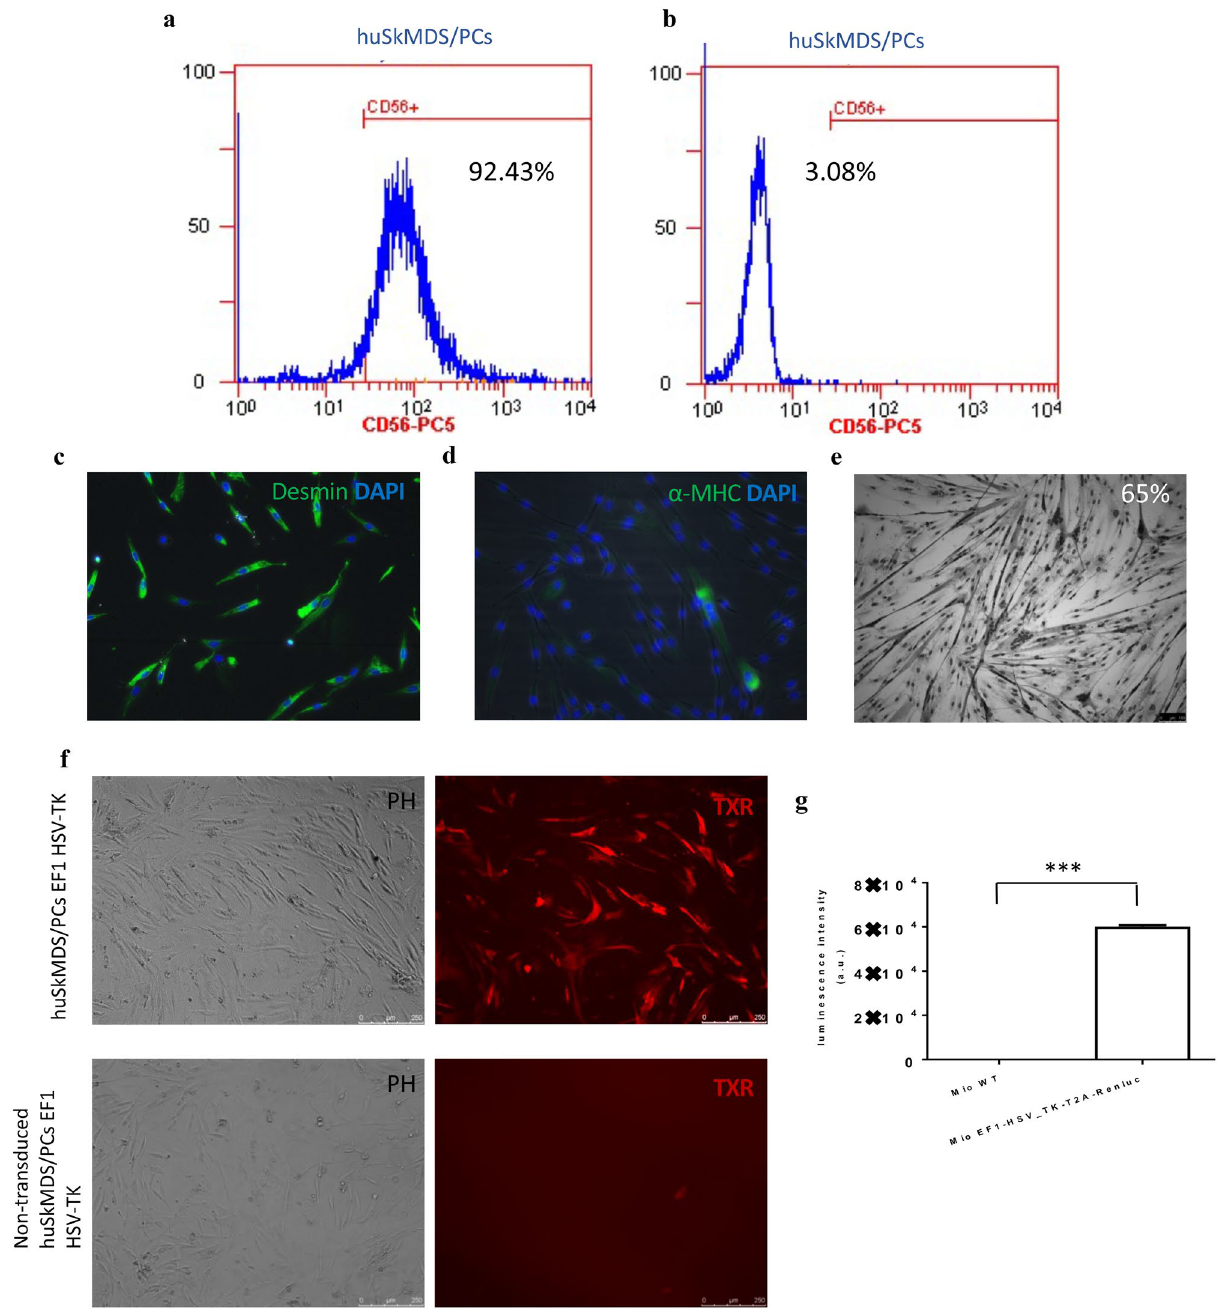
Figure 1. Myoblast characteristics. ( a ) Flow cytometry detected approximately 92% of CD56 + huSkMDS/PCs cells isolated from the skeletal muscle population. ( b ) Corresponding isotype control. ( c ) Immunofluorescent image of myogenic cells stained with anti-desmin antibody (green) and nuclear dye DAPI (blue). ( d ) Immunofluorescent image of myoblasts stained with anti-α-MHC (myosin heavy chain) antibody (green) with nuclear dye DAPI (blue). ( e ) Multinuclear tube formation test confirmed the ability of huSkMDS/PCs to differentiate in vitro, scale bar = 50 µm. ( f ) Positive expression of mCherry in EF1-HSV-TK transduced myogenic cells versus negative (non-transduced control), scale bar = 250 µm. ( g ) Luminescence intensity of Renilla measured in EF1-HSV-TK transduced huSkMDS/PCs vs. negative (non-transduced) control. Measurements were performed in triplicate for 5 × 10 4 cells each, and p-values are given as the mean ± SD; *p < 0.05, **p < 0.01, ***p <